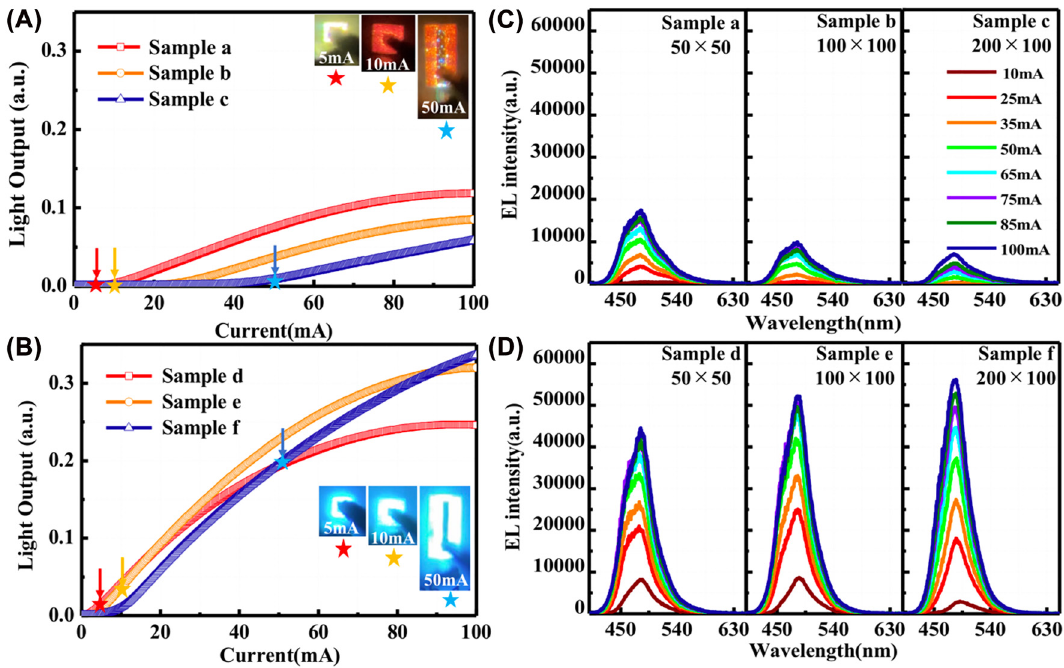
Figure 5: Light output and EL spectra of the samples with different chip sizes. (A) Light outputs of NW-LEDs in samples a, b, and c without (0001) plane etching. The insets show the optical microscopy emission photos taken at 5, 10, and 50 mA for samples a, b, and c, respectively. (B) Light outputs of samples d, e, and f with (0001) plane etching are plotted as a function of injection current. EL spectra of (C) samples a, b, and c without (0001) plane etching and (D) samples d, e, and f with (0001) plane dry etching at the NW apex